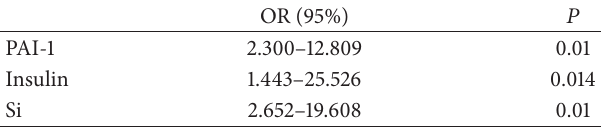
Table 4: Independent factors related to nondiabetics for develop- ment of ATIS in binary logistic regression